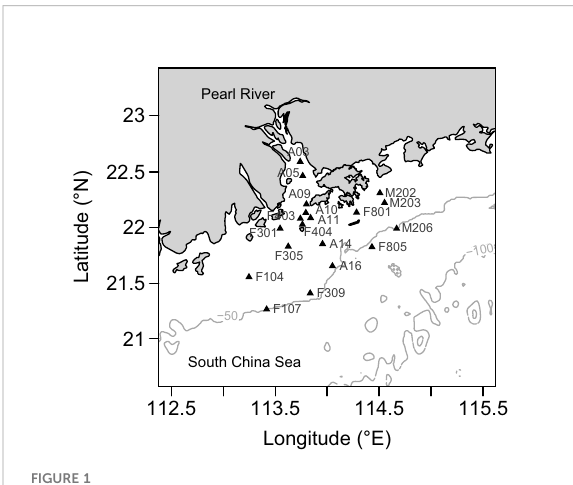
FIGURE 1 Map showing the sampling sites (indicated by fi lled triangles) in the Pearl River Estuary located in the northern South China